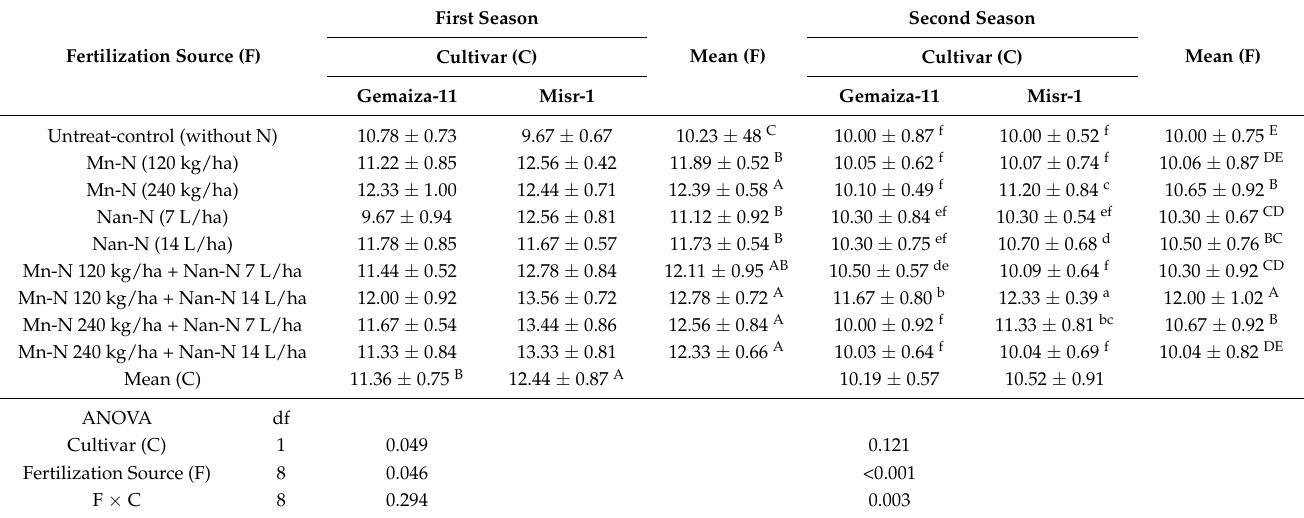
Table 6. Impact of nano- and mineral nitrogen fertilizers on the spike weight (g) of two